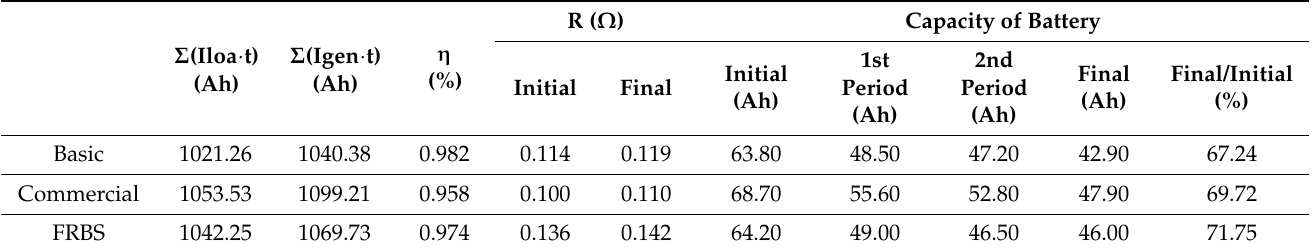
Table 2. Results of the second experiment with type B